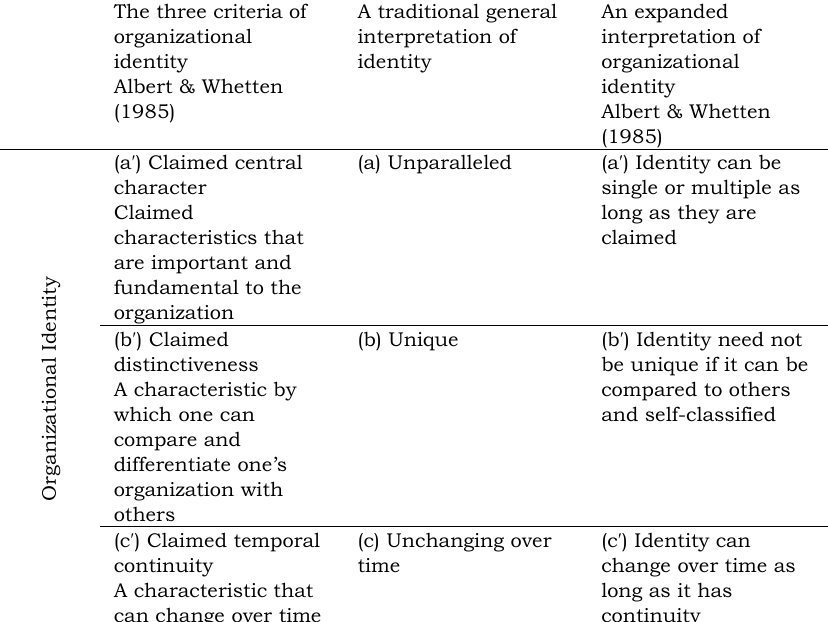
Table 2. Traditional general interpretation of identity, and Albert and Whetten’s (1985) expanded interpretation The three criteria